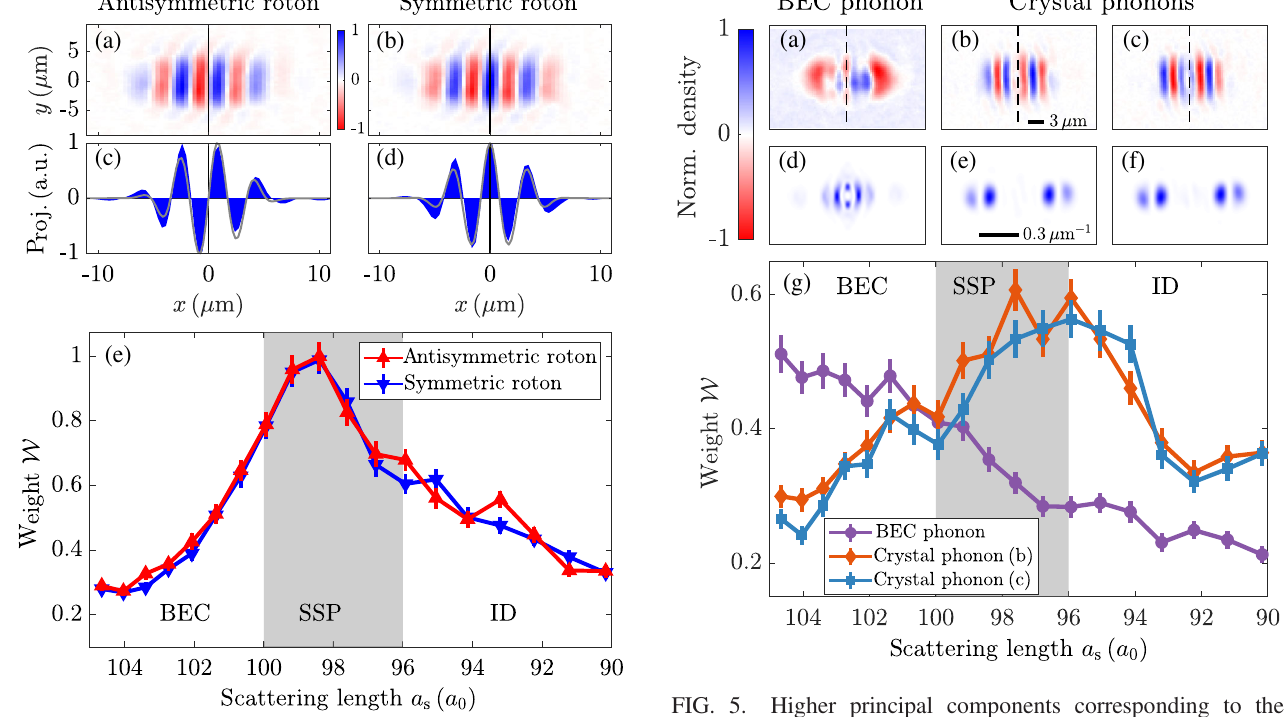
FIG. 4. (a),(b) Spatial structure of two principal components with the largest weight dominating the experimental dataset. (c), (d) Projections of (a),(b) onto the x axis (blue), with a comparison to the antisymmetric and symmetric roton density fluctuations from our BdG calculation [40] (gray). (e) Mean absolute weight W of the symmetric and antisymmetric roton, normalized to the weight of the antisymmetric roton mode at the transition point, which is the maximum weight of all principal components over the whole scattering length range. The roton modes are dominant, and their weights are almost degenerate from the BEC ( a s ¼ 104 . 7 a 0 ) leading up to the transition point ( a s ¼ 98 . 4 a 0 ). The gray area indicates the supersolid region previously determined [30]. Error bars indicate the standard error of the